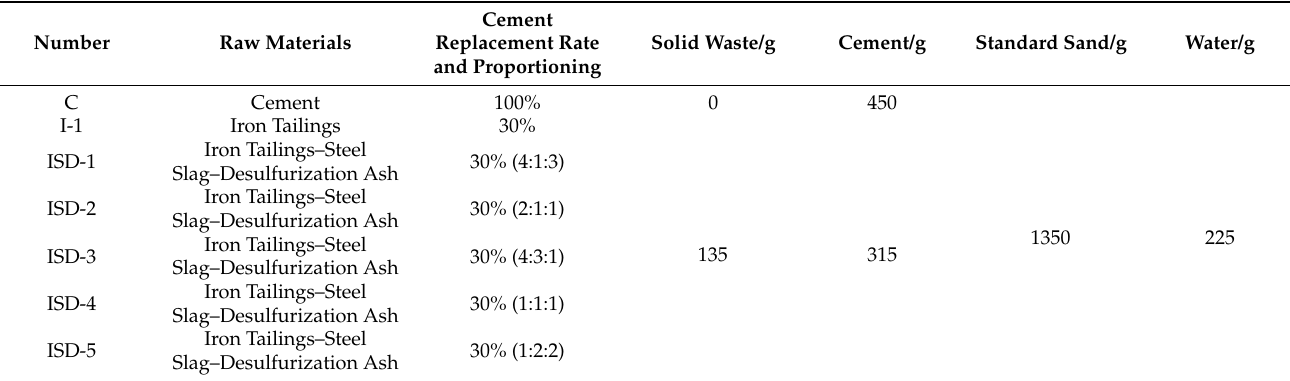
Table 2. ISD system material mix